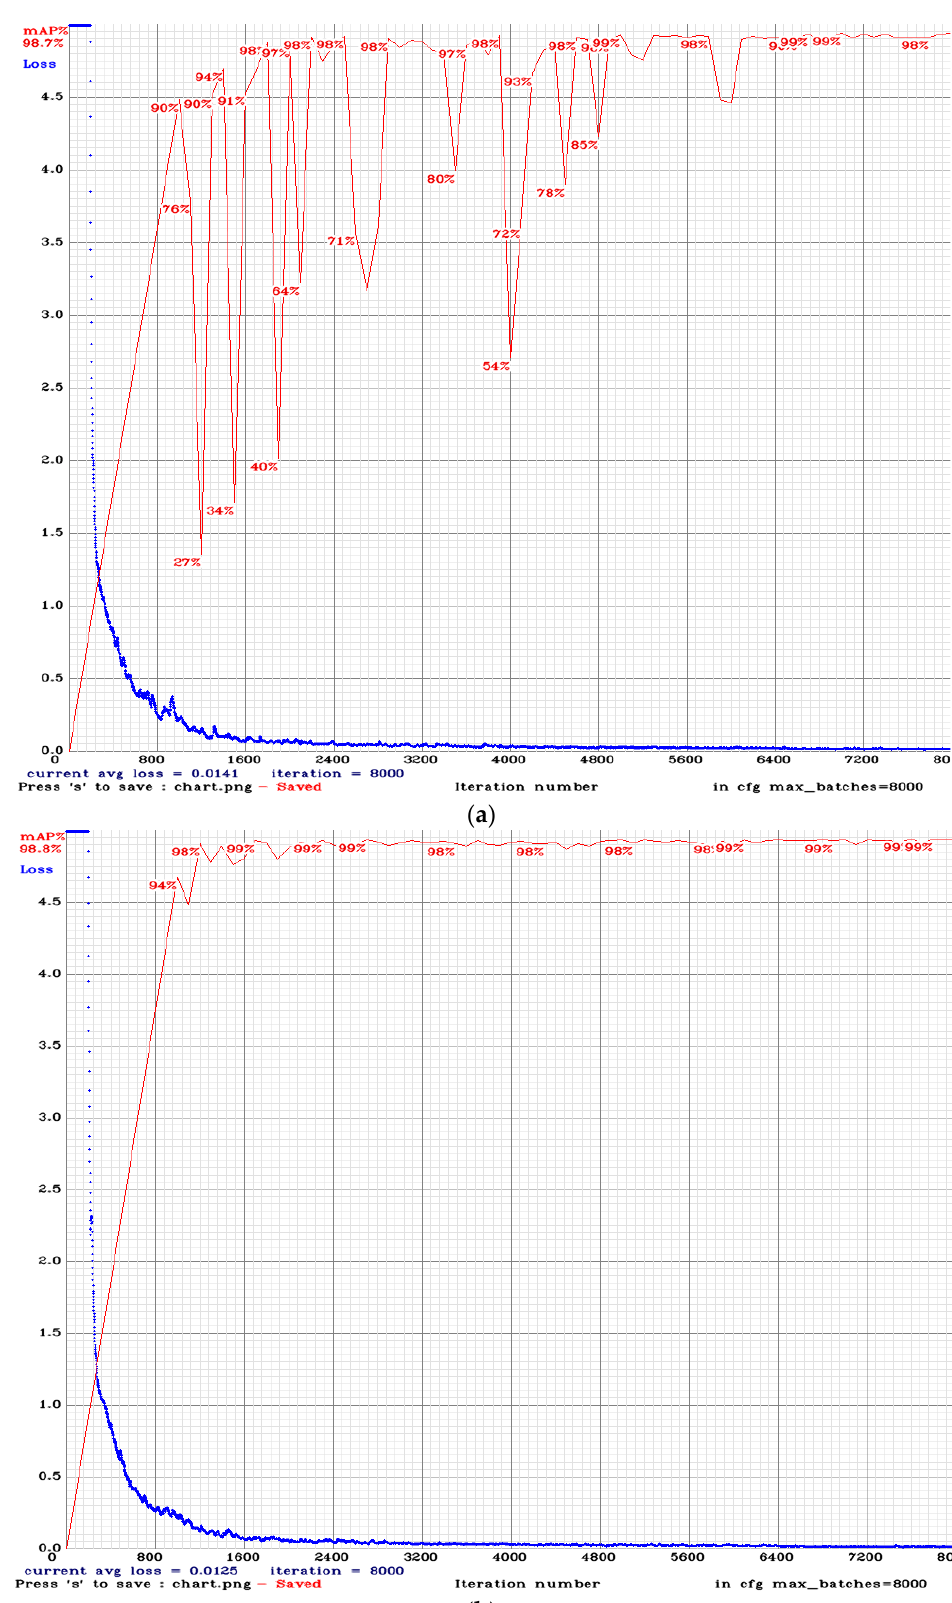
Figure 4. Training performance for all classes using (a) Yolo V3 1 and (b) Yolo V3 SPP 1. Table 2. Training loss value, mAP , and AP performance for all classes.